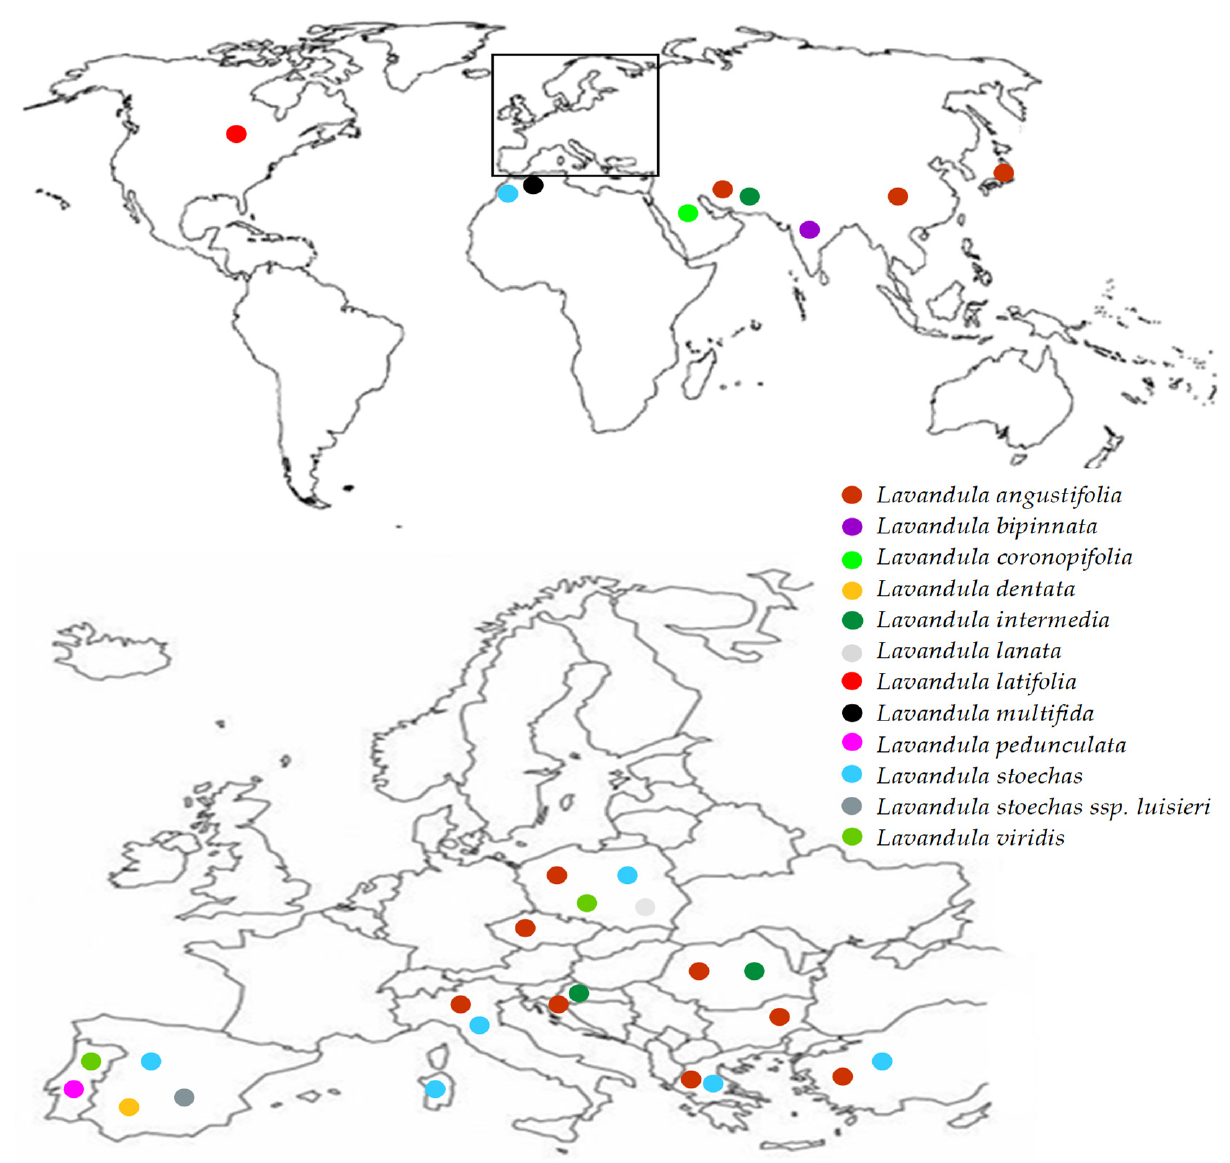
Figure 1. Global distribution map of various species belonging to the Lavandula genus. Inset: distribution of Lavandula in Europe.